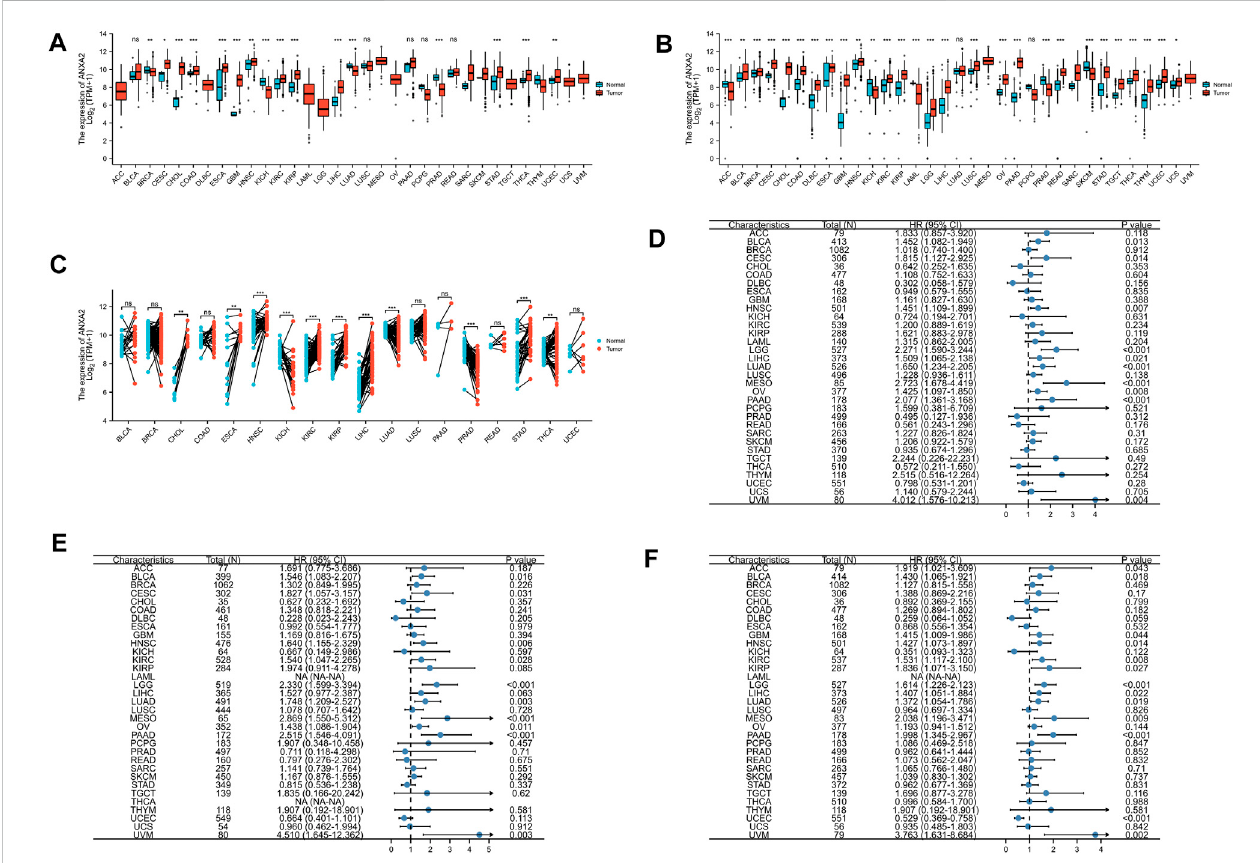
FIGURE 1 Differential expression and prognostic value of ANXA2 in pan-cancer. (A) Expression of ANXA2 gene in 33 cancers based on the data from the TCGA database. (B) Expression of ANXA2 gene in 33 cancers based on the data from TCGA and GTEx databases. (C) Expression of ANXA2 gene in paired samples based on the data from the TCGA database. Forest plot of (D) OS, (E) DSS and (F) PFI associated with ANXA2 expression in 33 types of cancer. * p < .05, ** p < .01 and *** p <